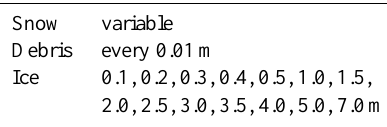
Table 2. Subsurface layer